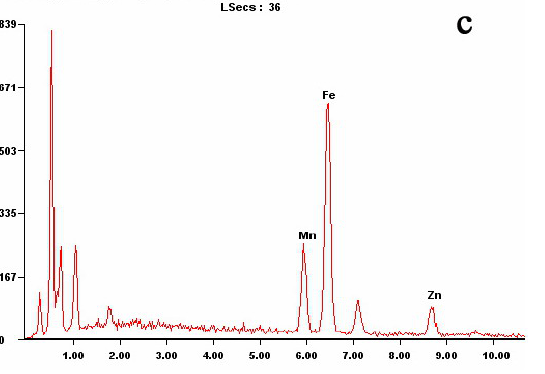
Figure 1. Characterization of Mn